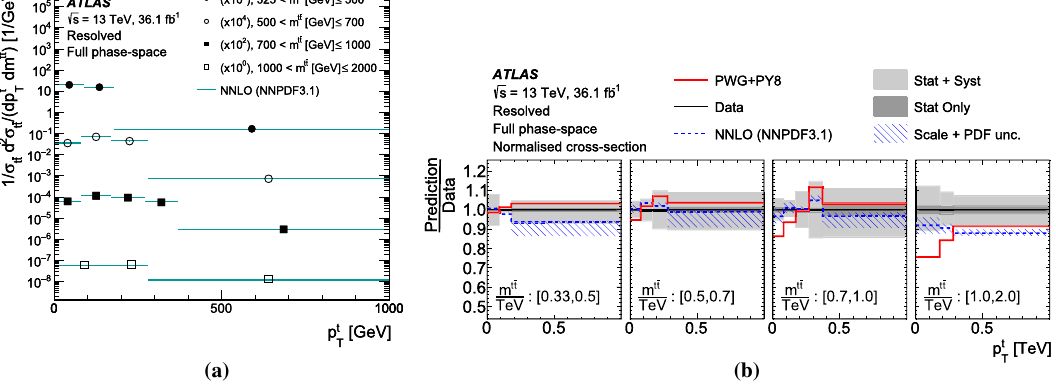
Fig. 60 a Parton-level normalised differential cross-section as a func- tion of p t in bins of m t ¯ t in the resolved topology compared with the T NNLO prediction obtained using the NNPDF3.1 NNLO PDF set. Data points are placed at the centre of each bin. b The ratio of the measured